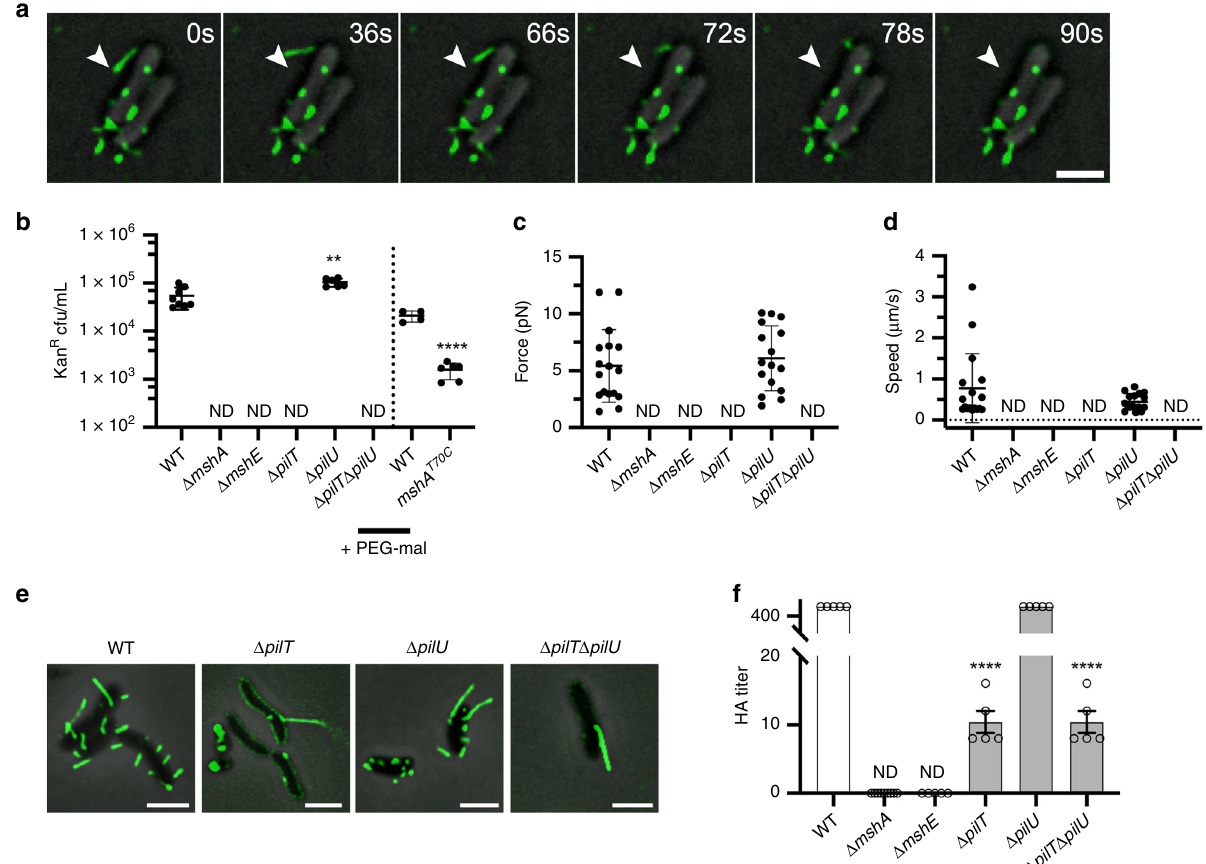
Fig. 2 MSHA are dynamic retractile pili, and retraction is requisite upon the PilT ATPase. a Time-lapse visualization of MSHA retraction in surface- associated mshA T70C cells labeled with AlexaFluor 594 C 5 maleimide. Images were collected every 6 seconds over 10 min. White arrow in all images marks the tip of the retracting pilus at t = 0. Numerous retraction events were observed over multiple biological replicates (see Supplementary Movies). Scale bar = 2 μ m. b Transduction of VGJ Φ is dependent upon production of MSHA pili. Individual data points plotted with line at the mean and error bars representing the standard deviation. Biological replicates: WT n = 8, Δ mshA n = 6, Δ mshE n = 6, Δ pilT n = 6, Δ pilU n = 6, Δ pilT Δ pilU n = 6. Statistical analysis: unpaired two-tailed Student ’ s t -Test, ** p = 0.0024. ND no detected kanamycin-resistant colonies. Data to the right of Dashed-line: WT and mshA T70C cells treated with 4.2 mM MeOH-PEG-mal in DMSO prior to introduction of VGJ Φ . Individual data points plotted with line at the mean and error bars representing the standard deviation. Biological replicates: WT n = 4, mshA T70C n = 6. Statistical analysis, unpaired two-tailed Students t -Test, **** p ≤ 0.0001. Source data provided as a Source Data fi le. c Average force of MSHA retraction determined by micropillars assay. Individual data points plotted with line at mean and error bars representing the standard deviation. ND no retraction events detected. Biological replicates: WT n = 17 and Δ pilU n = 16. Statistical analysis of WT vs. Δ pilU , unpaired two-tailed Students t -Test, not signi fi cant p = 0.5291. Source data provided as a Source Data fi le. d Average speed of MSHA retraction determined by micropillar assay. Individual data points plotted with line at mean and error bars representing the standard deviation. ND no retraction events detected. Biological replicates: WT n = 17 Δ pilU n = 16. Statistical analysis of WT vs. Δ pilU , unpaired two-tailed Students t -Test, not signi fi cant p = 0.1428. Source data provided as a Source Data fi le. e Representative overlay images of fi ltered- fl uorescence and phase-contrast channels from ATPase mutants in the mshA T70C strain within surface-associated cells stained with AlexaFluor 488 C 5 maleimide dye. Images representative of three independent analyses. Scale bars = 2 μ m. f Analysis of surface MSHA production via hemagglutination (HA) assay. The reciprocal of the lowest fold dilution at which equivalent cell levels were able to agglutinate sheep erythrocytes (HA Titer) is plotted as the mean with error bars representing the SEM. For each strain n = 5 biological replicates were analyzed, with two technical replicates performed for each biological replicate. ND no observable hemagglutination at the highest cell concentration. Statistical analysis: each mutant HA titer was compared to WT via unpaired two-tailed Student ’ s t -Test, **** p ≤ 0.0001. Source data provided as a Source Data fi